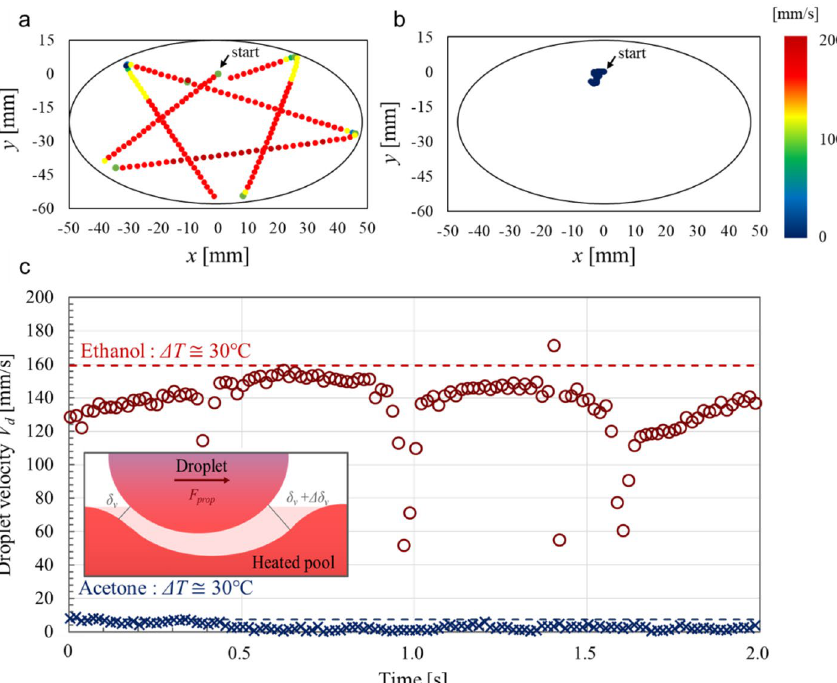
Figure 3. Self-propulsion of ethanol and acetone droplets. The trajectory of the droplets at a given time is shown. The initial position of the droplets is represented by the origin. ( a ) Ethanol droplet with ΔT The trajectory represents the first 3 s of droplet motion. ( b ) Acetone droplet with ΔT represents the entire droplet motion over a duration of 14 s. ( c ) Comparisons of the experimental data against the model prediction of droplet self-propulsion. The red circles ( 〇 ) and blue crosses ( × ) represent the experimental results for the ethanol and acetone droplets, respectively. The terminal velocities V t d predicted using Eq. (5) are represented as dashed lines (red for ethanol, blue for acetone). The inset indicates the model for the self-propulsion of the